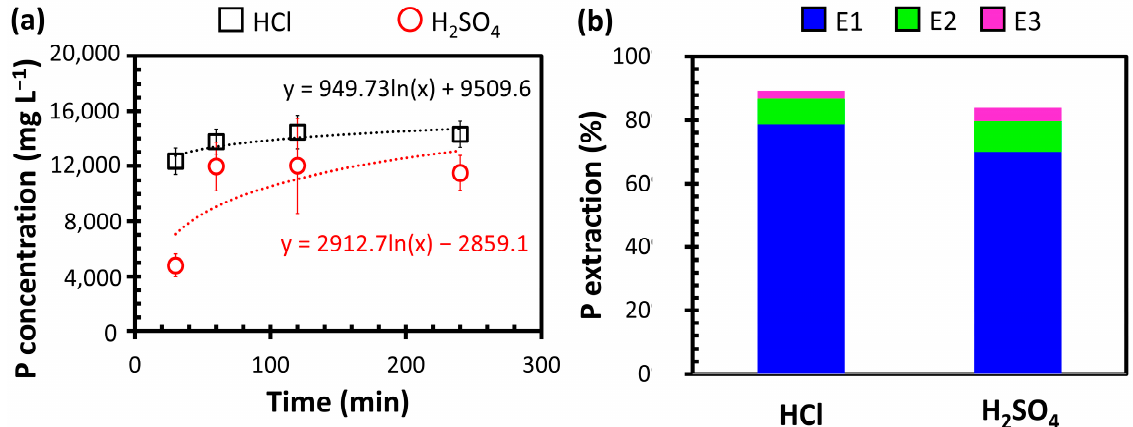
Figure 2. P extraction in crossflow mode. ( a ) Kinetics of P extraction during the first acid attack with the addition of H 2 SO 4 and HCl. ( b ) P extracted in each of the three sequential acid attacks (E1, E2, and E3). The analysis of P content was performed by ICP-OES. (n = 2).